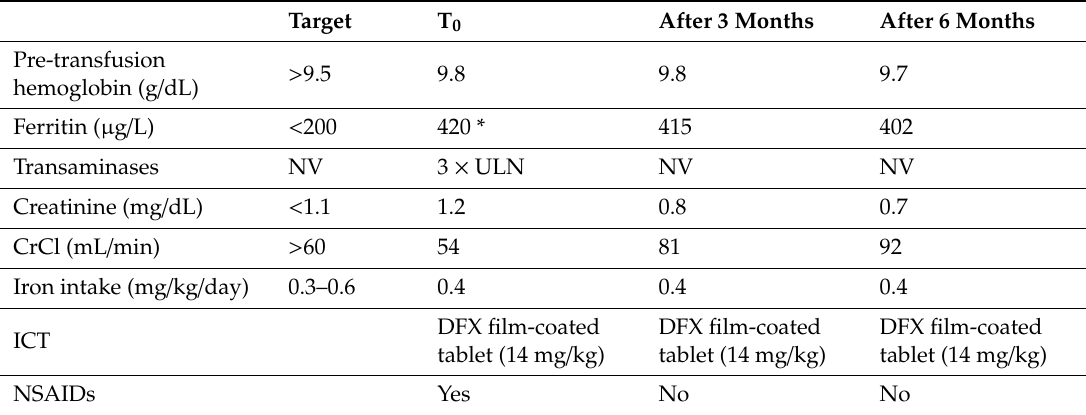
Table 2. Case 2: 40-year-old patient with transfusion-dependent β -thalassemia major with renal function alteration and serum ferritin < 500 µ g / L. Target T 0 After 3 Months After 6